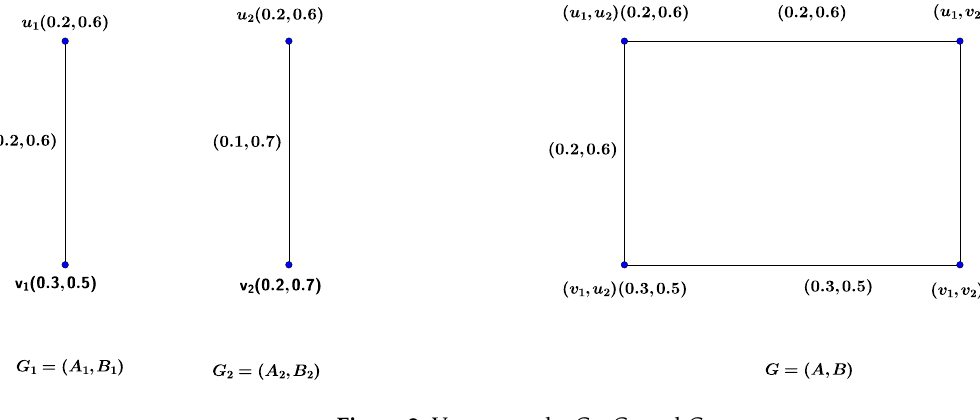
Figure 2. Vague graphs G 1 , G 2 and G